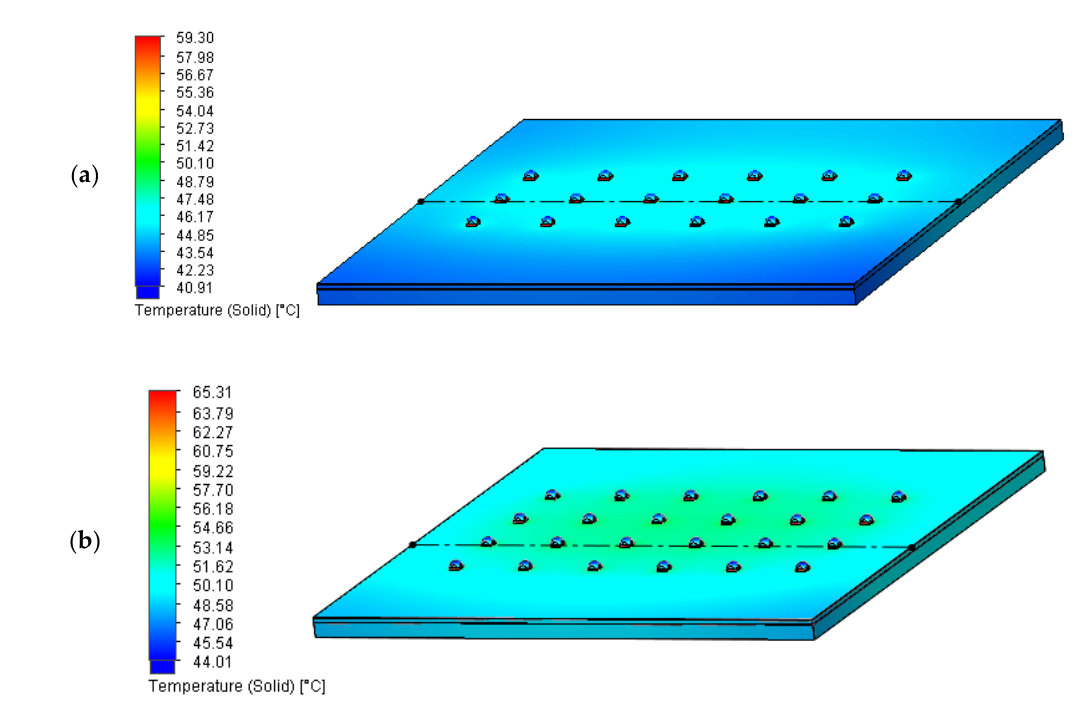
LED panels along the axis discussed above is shown in Figures 10 and 11. The maximum LED source junction temperature for all panel configurations with a different number of sources is summarized in Table 2. Figure 9. Temperature distribution of the LED panel at I F = 700 mA: ( a ) 3 × 6, ( b ) 4 × 6 . For the 3 × 6 panel, the maximum junction temperature T j for a LED located in the center of the panel was T j = 59.30 °C, while increasing the number of LEDs to 4 × 6 resulted in an increase in the maximum temperature T j of the central light source to a value of 65.31 °C, which was an increase of about 10%. The dotted line (Figure 8) marks the axis of de- termination of the temperature distribution along the length of the LED panel, where the highest temperatures T j of the installed LEDs occur. Temperature distribution of the tested